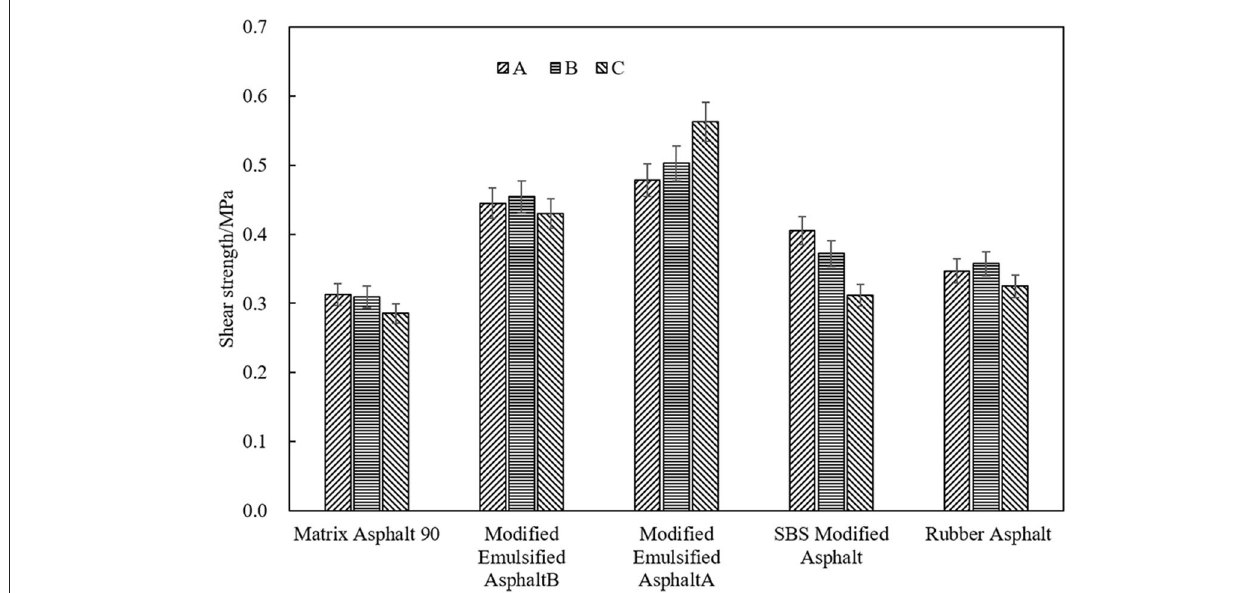
FIGURE 7 | Interfacial shear strength at different tack coat.